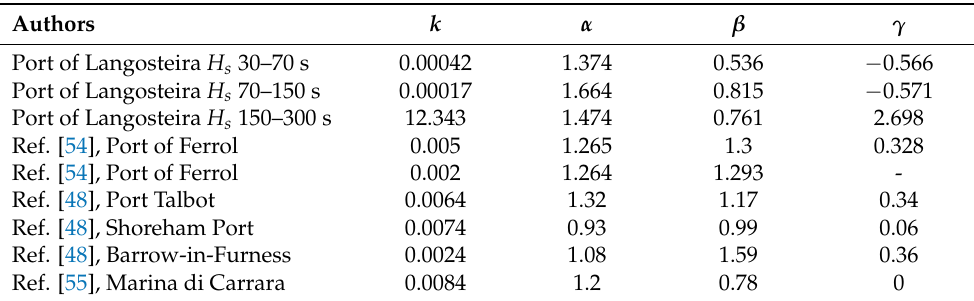
Table 2. Coefficients k, α , β and γ obtained from the fitting to the classical formula, and comparison with those of other